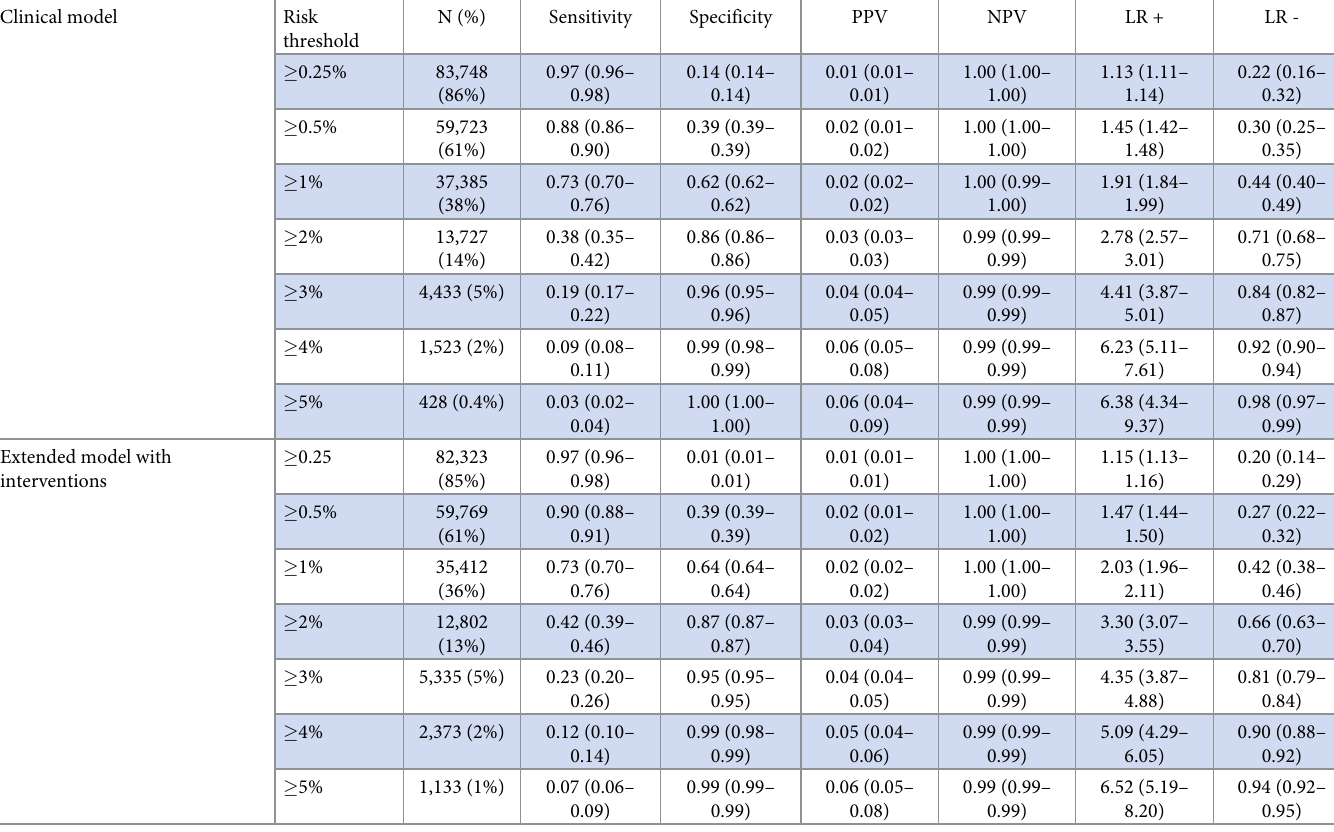
Diagnostic accuracy of different risk thresholds of the prediction models. The individual risk predictions are based on average risk predictions across the 25 imputed datasets; n = 97,269 children out of n = 98,561 had risk predictions. Overall prevalence of serious illness was 1.0%. PPV: positive predictive value; NPV negative predictive value; LR likelihood